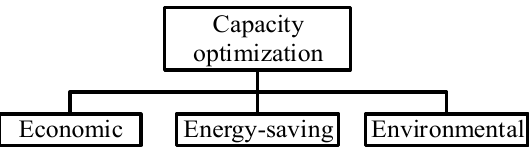
Figure 2. The structure diagram of AHP.